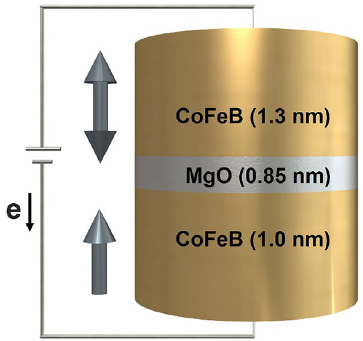
Figure 1. Schematic of the MTJ nanopillar of CoFeB (1.0 nm)/MgO (0.85 nm)/CoFeB (1.3 nm) with perpendicular magnetic anisotropy.